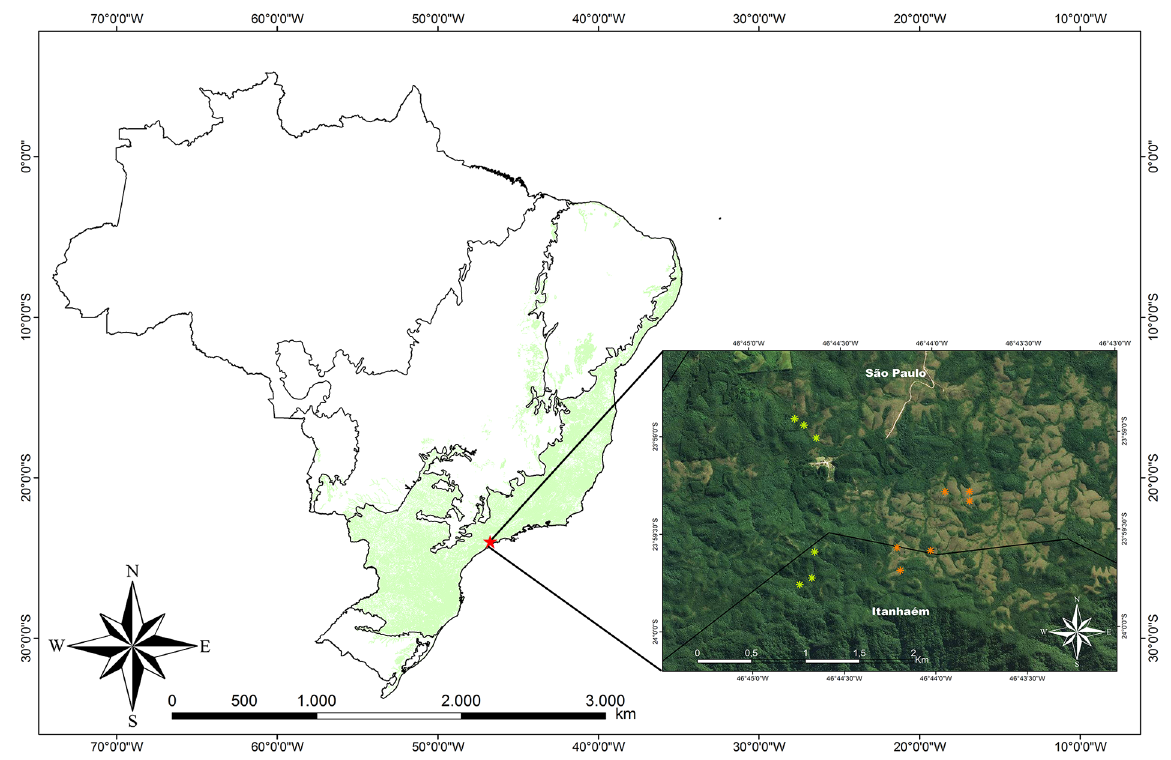
Figure 1. Location of the sampled area. Remnants of Atlantic Forest are in green. Red star represents the location of Curucutu nucleus. The mosaic open fields and cloud forest physiognomies of Curucutu nucleus, and the distribution of sample units, are shown in the detail to the